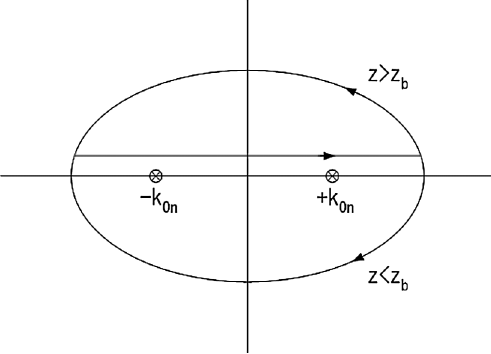
FIG. 1. Contours for integration in the complex k plane for Cerenkov radiation.